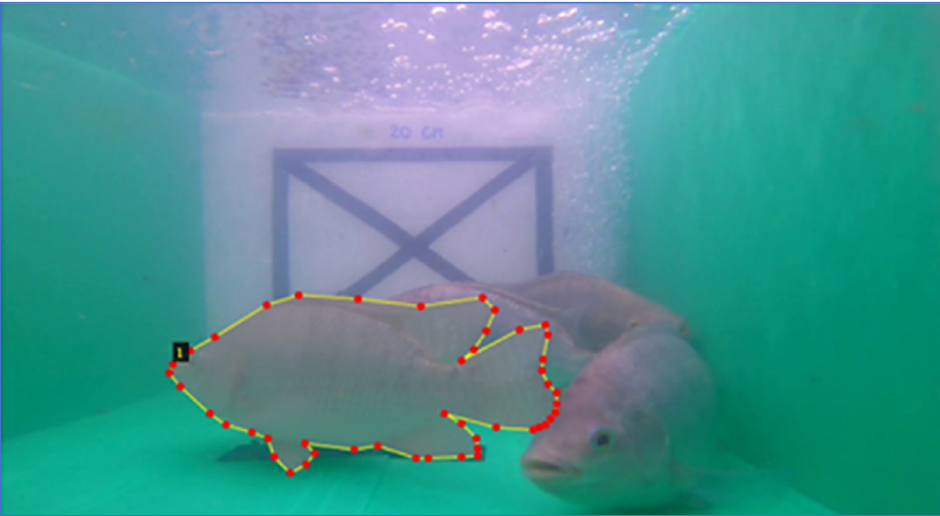
Figure 4. Comparison between original images ( left ) and enhanced images ( right ).